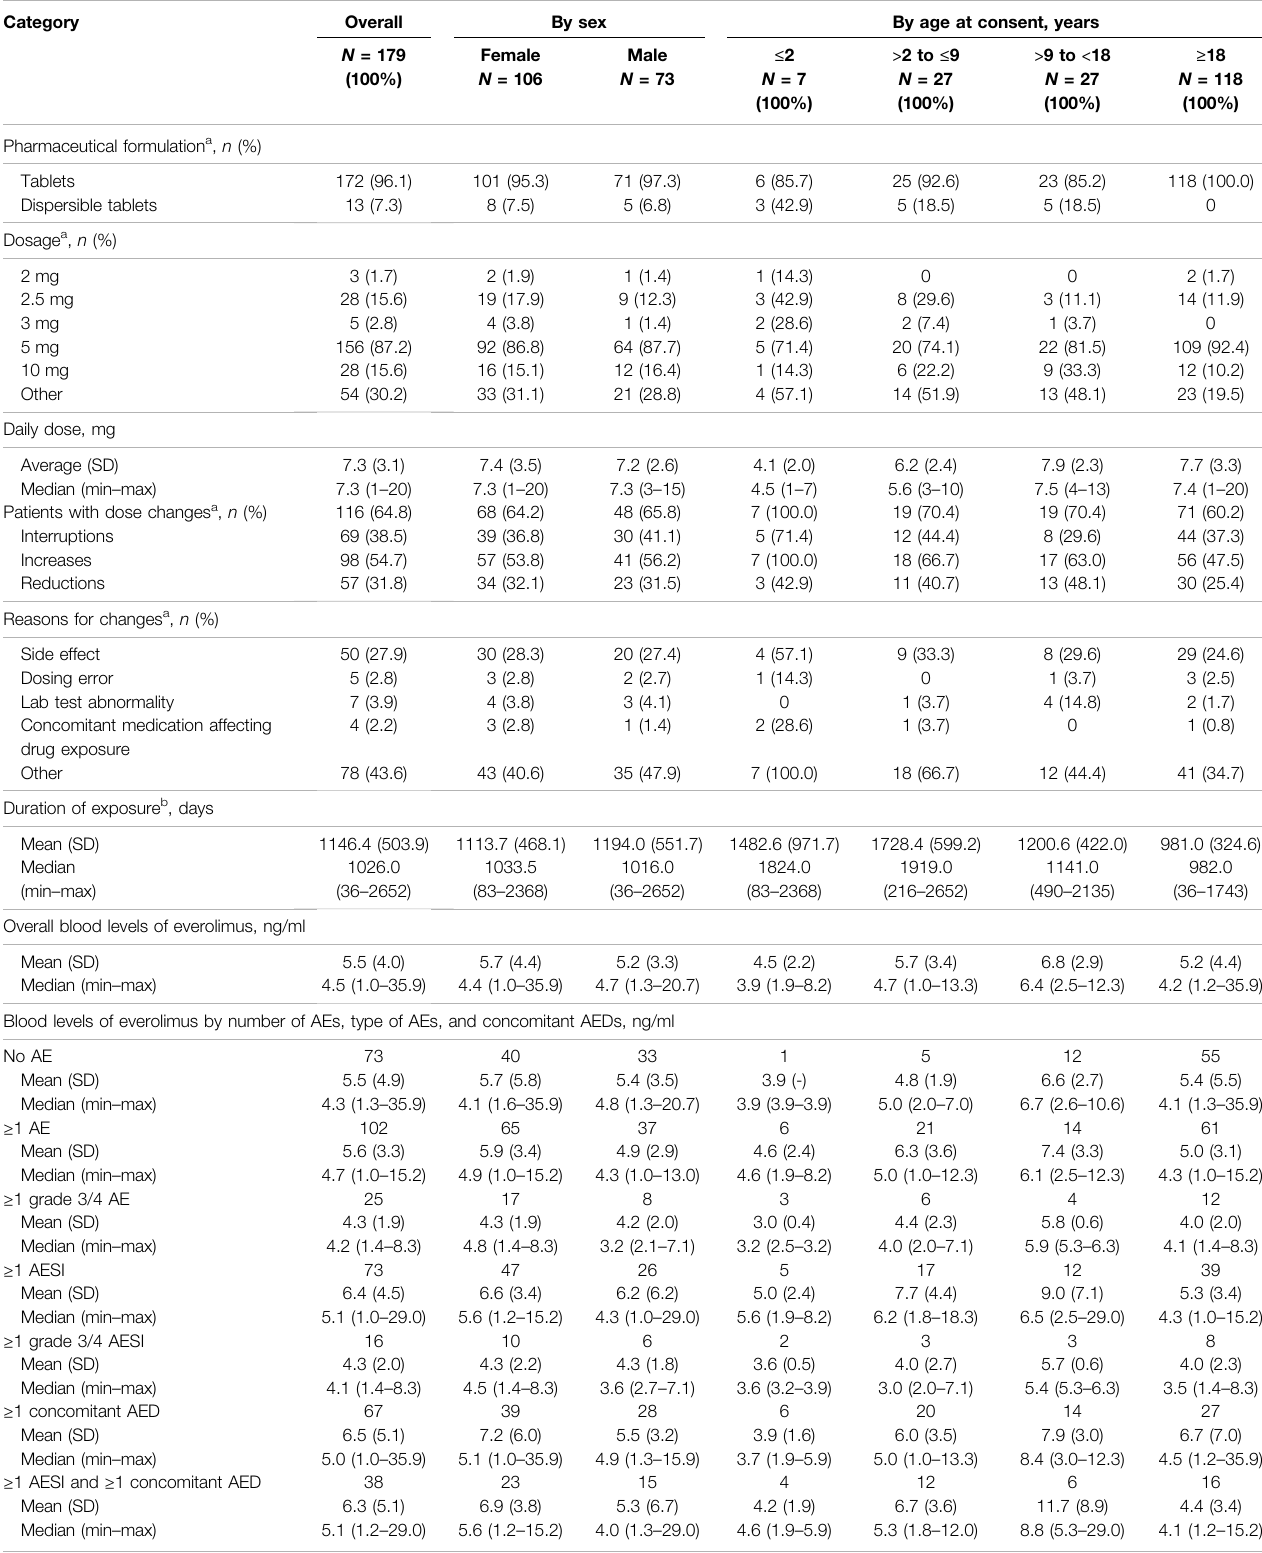
TABLE 1 | Everolimus dosage, exposure, and safety for the overall population, by sex, and across age groups.